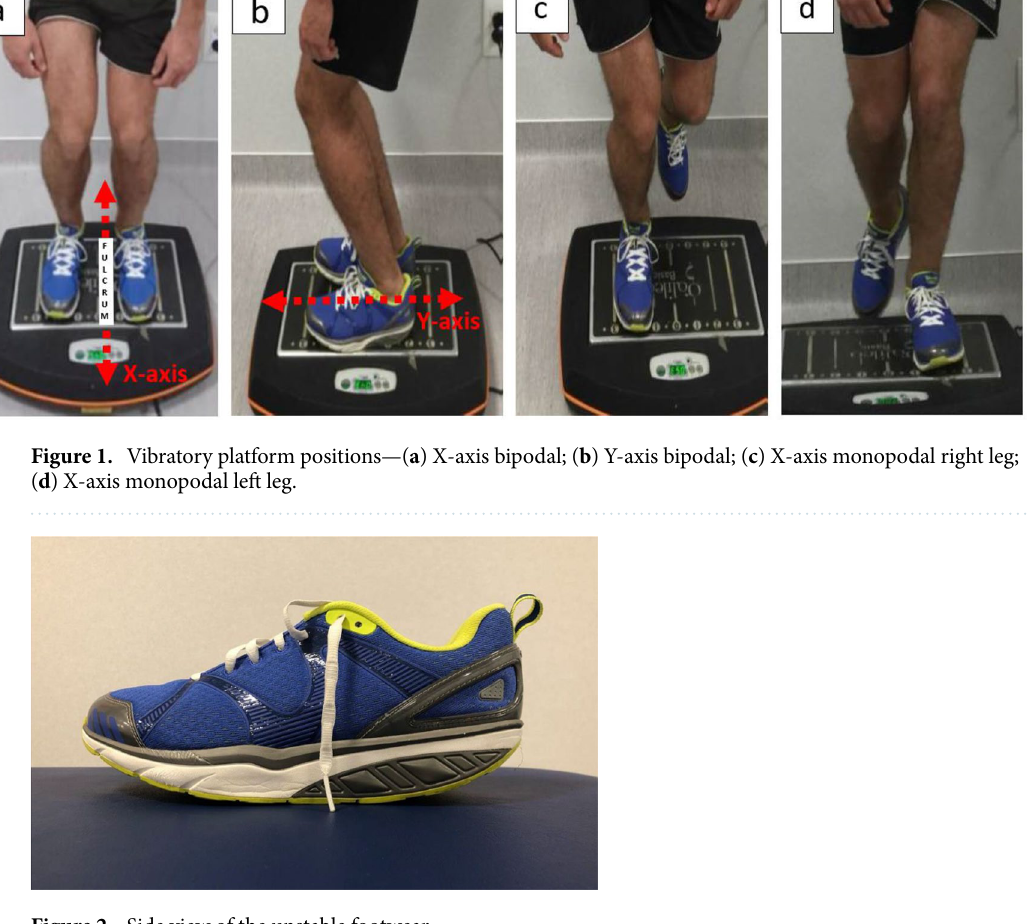
Figure 2. Side view of the unstable